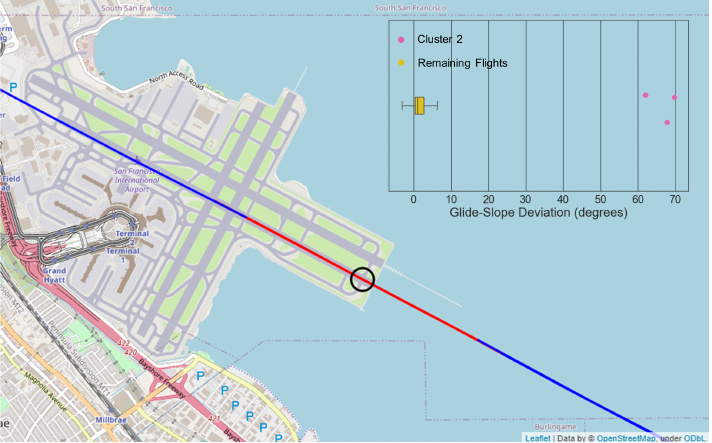
Figure 6. Example of a flight that was placed into the “Other Cluster”. The black circle represents the minimum altitude point prior to go-around. The box-plot in the top right compares the glide-slope deviation of flights in Cluster 2 with the remaining flights. The folium (http://python-visualization. github.io/folium/, accessed on 1 September 2021) Python library was utilized to generate the